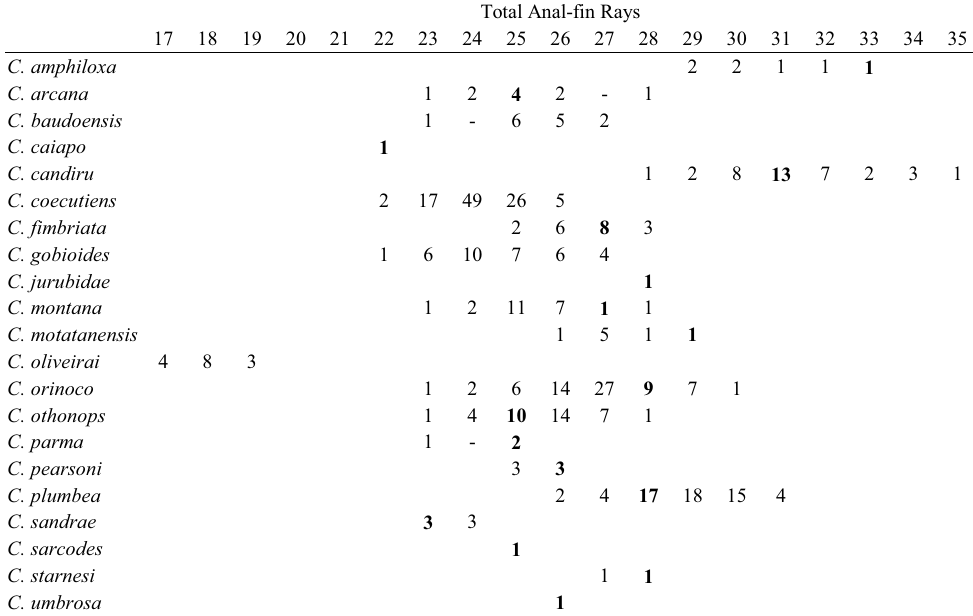
Table 11. Number of specimens of the species of Cetopsis with cited number of total anal-fin rays. Bold indicates value for holotype or lectotype when examined.